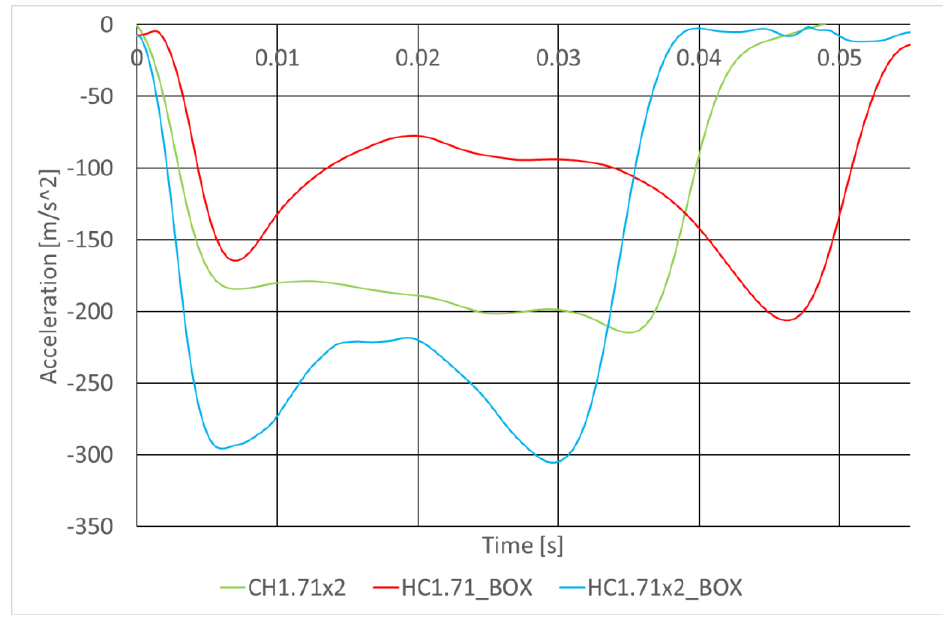
Figure 23. Acceleration vs. time curves.